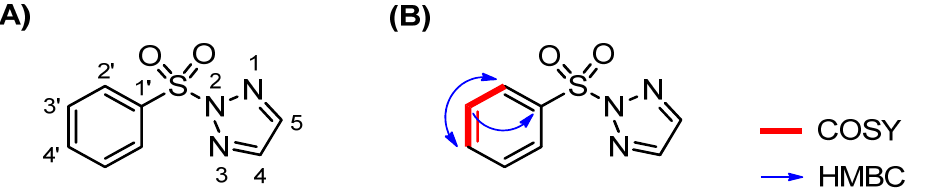
Figure 3. ( A ) Structure of 2 ‐ (phenylsulfonyl) ‐ 2 H ‐ 1,2,3 ‐ triazole 3 . ( B ) Connectivities of 3 based on COSY (bold red line) and HMBC (from H to C, blue arrow) data. Table 1. 1 H and 13 C{ 1 H} NMR assignments, COSY, NOESY, and HMBC correlations of 3 a .